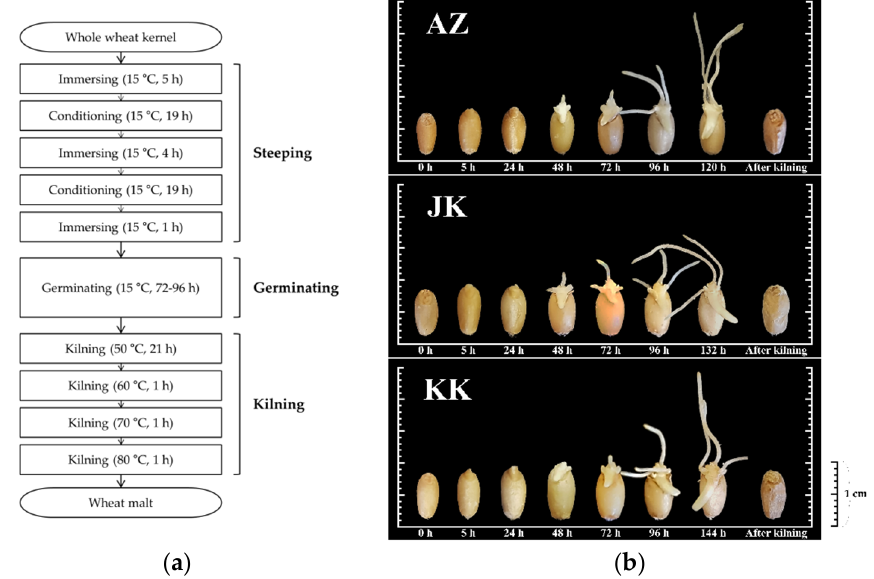
Figure 1. Micromalting procedure ( a ) and representative images of changing wheat kernels during the micromalting ( b ). AZ, JK, and KK represent Triticum aestivum L. var. Anzunbaengi , Jokyung , and Keumkang , respectively.